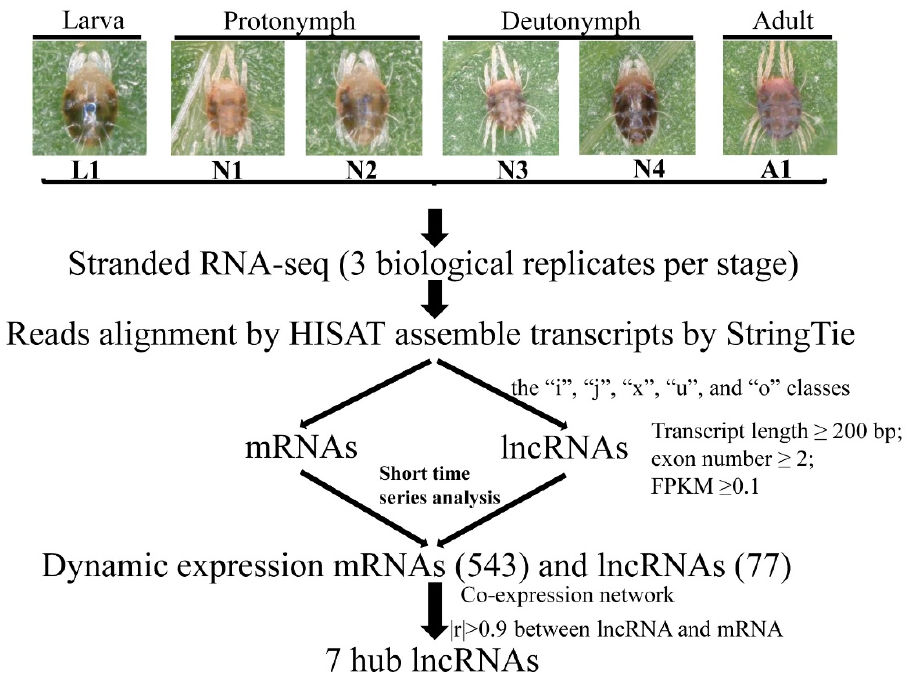
Figure 1. The experimental synthesis outline for sampling and sequencing in the molting process of different development stages.